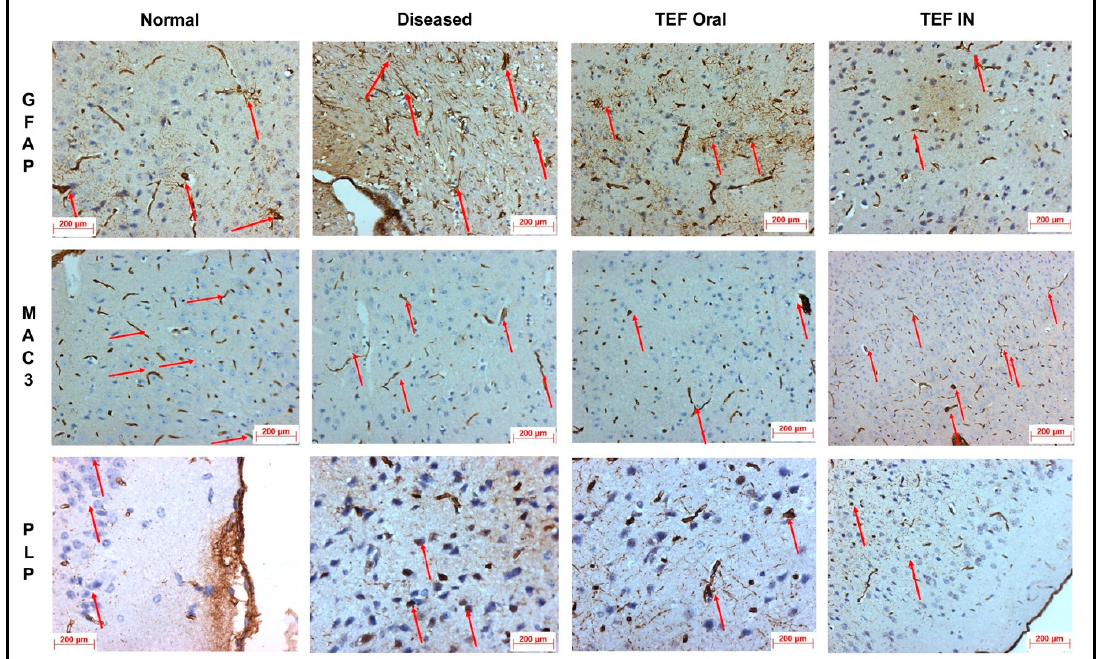
Figure 9. The sections of cerebral cortex. The degree of astrocytosis was measured by IHC of the study groups by GFAP protein immunoreactivity. The macrophages and microglia were measured by IHC of the study groups by MAC3 protein immunoreactivity. The degree of myelin loss was measured by IHC of the study groups by PLP protein immunoreactivity. The images inferred that– IN-administered TEF–miR-155-antagomir-loaded NLCs group has exhibited signi fi cant recovery with minimal immunopositive reactivity compared to TEF oral group. (Red arrows indicate immu- noreactivity).